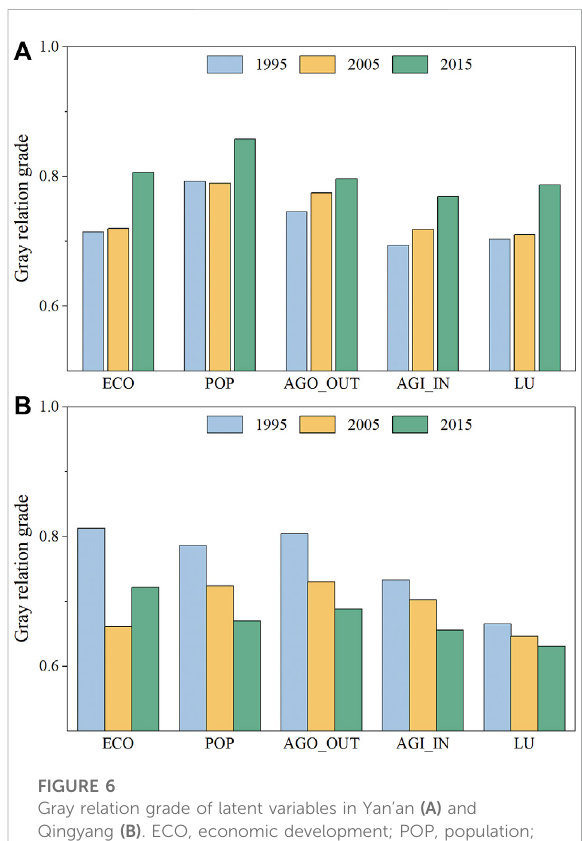
FIGURE 6 Gray relation grade of latent variables in Yan ’ an (A) and Qingyang (B) . ECO, economic development; POP, population; AGO, agricultural output; AGI, agricultural input; LU, land use.